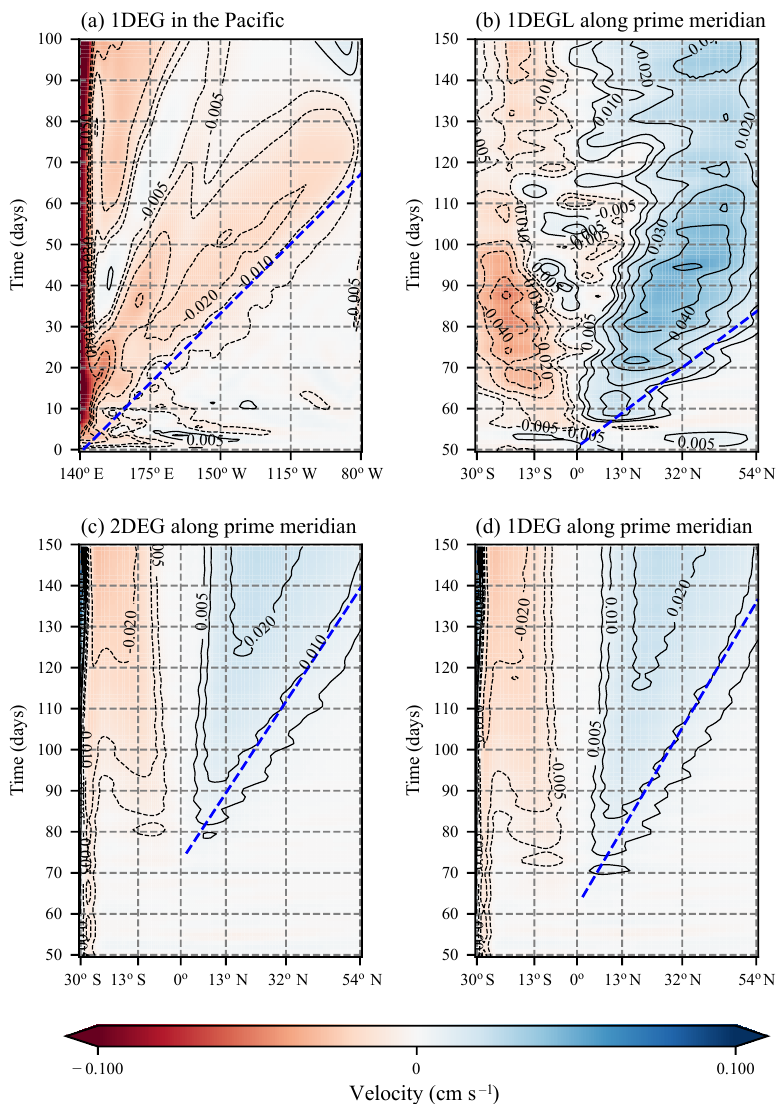
Figure 5. The Kelvin wave phase speed in Veros approximately only depends on viscosity, not resolution, as predicted by Marshall and Johnson (2013). (a) Zonal velocity in 1DEG at the Equator and (b–d) meridional velocity in 1DEGL, 2DEG, and 1DEG, respectively, along 0 ◦ longitude in the Atlantic at 200m of depth. The slopes of the blue dashed lines are used to estimate phase speeds. Note that the signal arrives at different times at the African coast due to the location of the maximum wind field perturbation, which is not at the South American coast. Thus, the buoyancy perturbation that eventually arrives in the North Atlantic has to be advected to the South American coast before it can travel north as a fast coastal